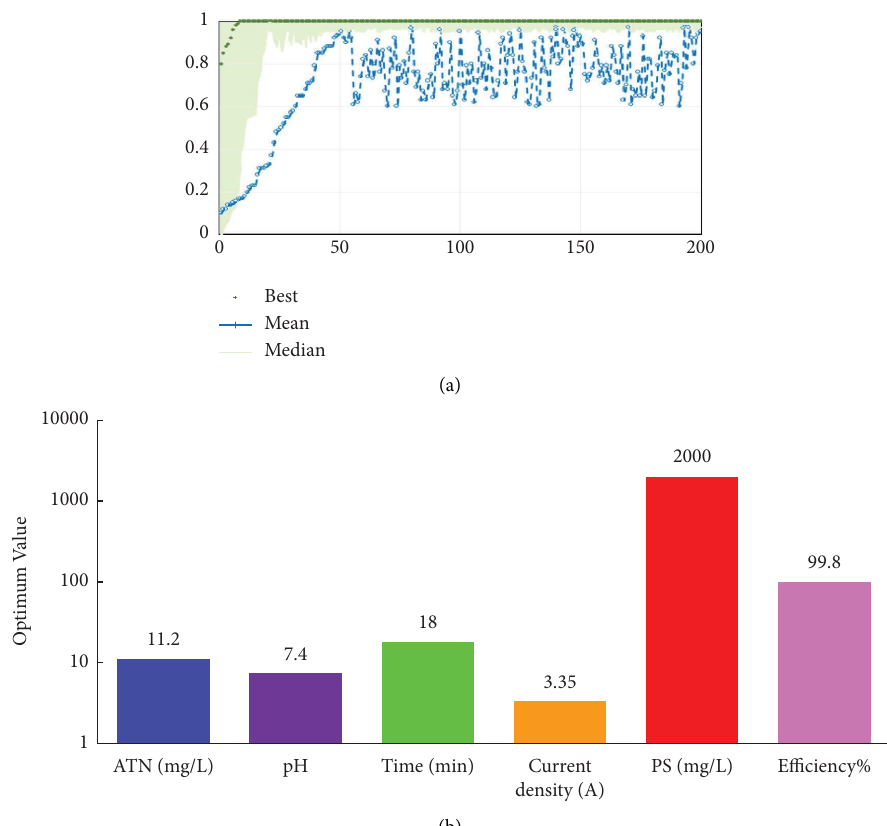
Figure 4: Genetic algorithm results. (a) Te best and average ftness values per generation. (b) Te optimal value of the input parameters and highest removal